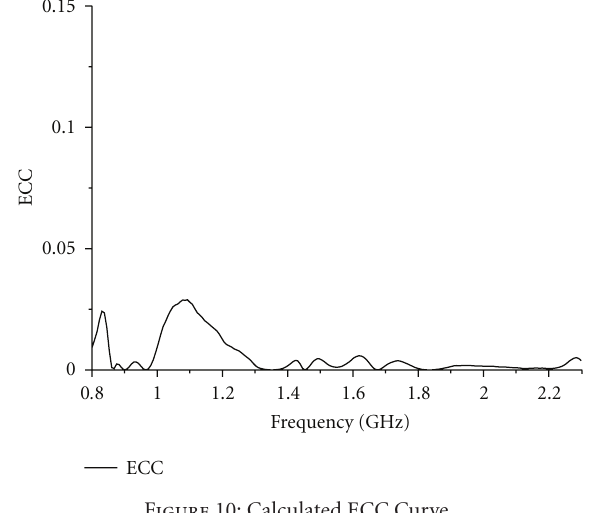
Figure 10: Calculated ECC